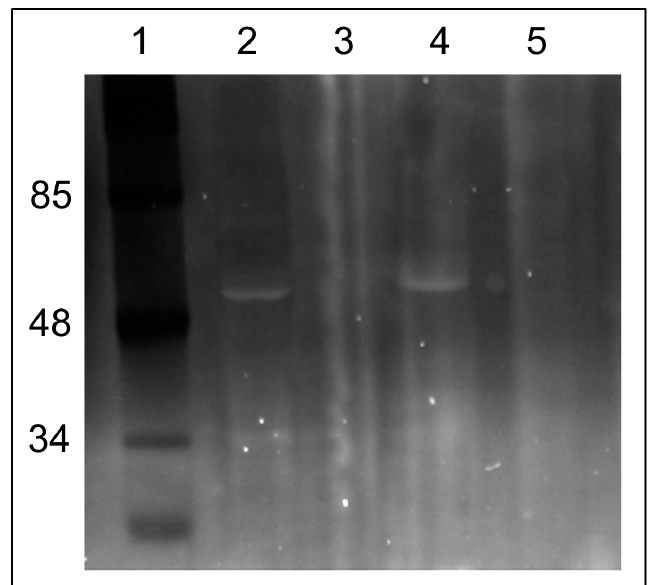
Figure 7. Fluorescent image of the gel after SDS electrophoresis of solubilized rat liver mitochondria (RLM) or extracts of B. subtilis exposed to C4R1 (5 µ M). Lanes: 1. MW markers; 2. RLM+C4R1; 3. Blank well; 4. RLM+C4R1; 5. B. subtilis +C4R1. Note the fluorescing band in RLM extracts at around 50 kDa.